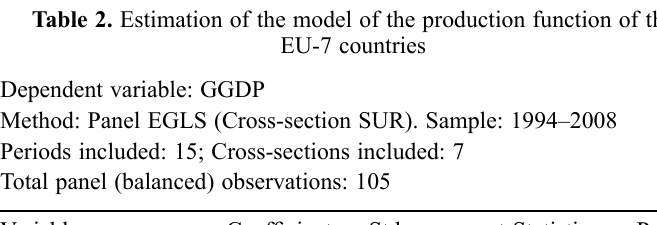
Table 2. Estimation of the model of the production function of